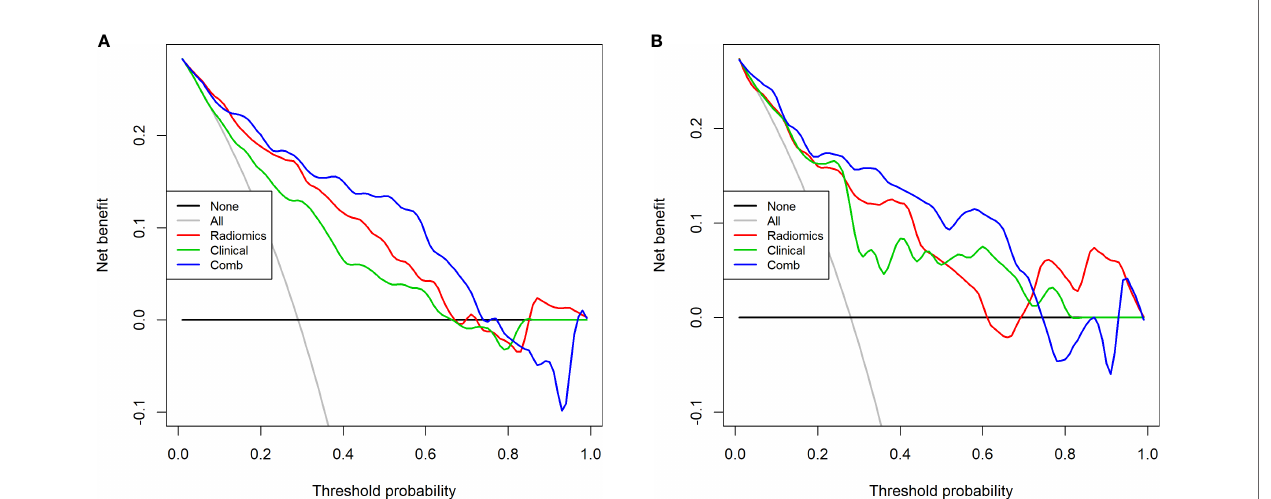
FIGURE 7 | Decision curve analysis of the 3 models in the training cohort (A) and testing cohort (B) . The decision curve analysis (DCA) showed that the combined model yielded higher net bene fi t than the clinical model and the radiomics model, when the score is within a probability range from 0 to 0.720 in the training cohort and range from 0 to 0.728 in the testing